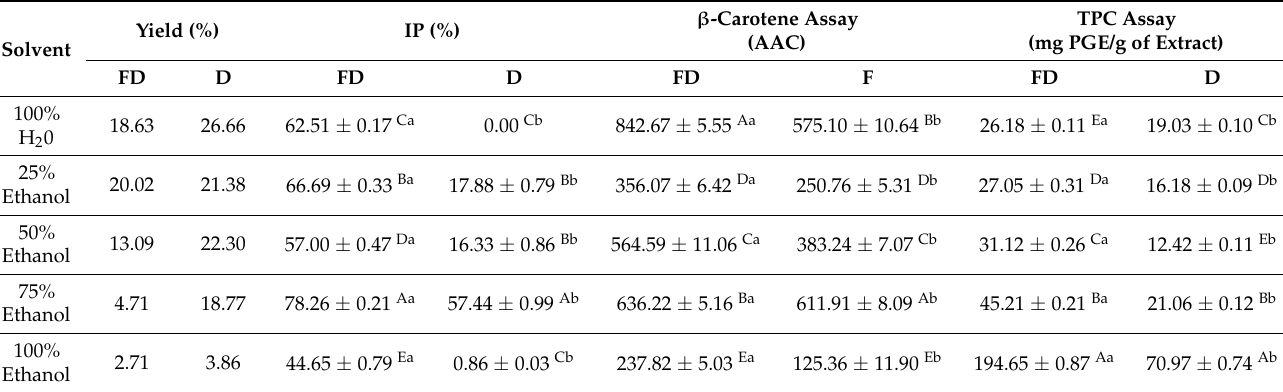
β -Carotene Assay TPC Assay (AAC) (mg PGE/g of Extract)